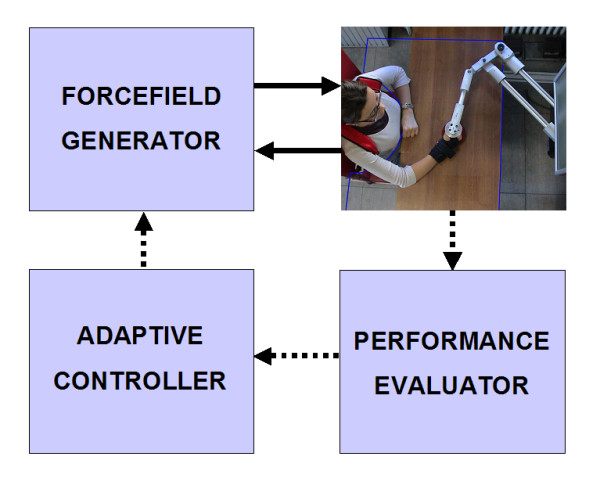
Control scheme. The Force field generator uses an impedance control scheme, with the direct drive of the robot actuators, in such a way to transmit to the handle a force vector computed as a function of the kinematic state of the robot (sampling frequency: 1 kHz). The Adaptive Controller modulates the gain of the force field as a function of the evaluated performance, according to a non-monotonic training protocol. Continuous vectors: continuous time control; Dotted vectors: intermittent control.